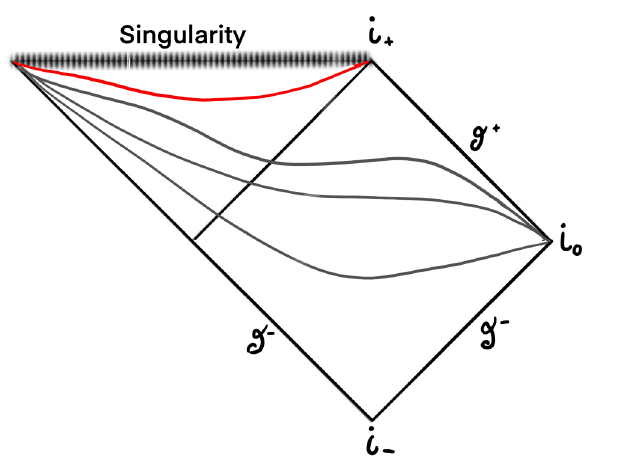
Figure 1. Schematic Penrose diagram of the Lorentz violating geometry. Rays travelling at speed larger than c correspond to straight lines with inclination larger than 45 ◦ and can escape the Killing horizon. The gray lines represent lines of constant khronon T , while the red line denotes the universal